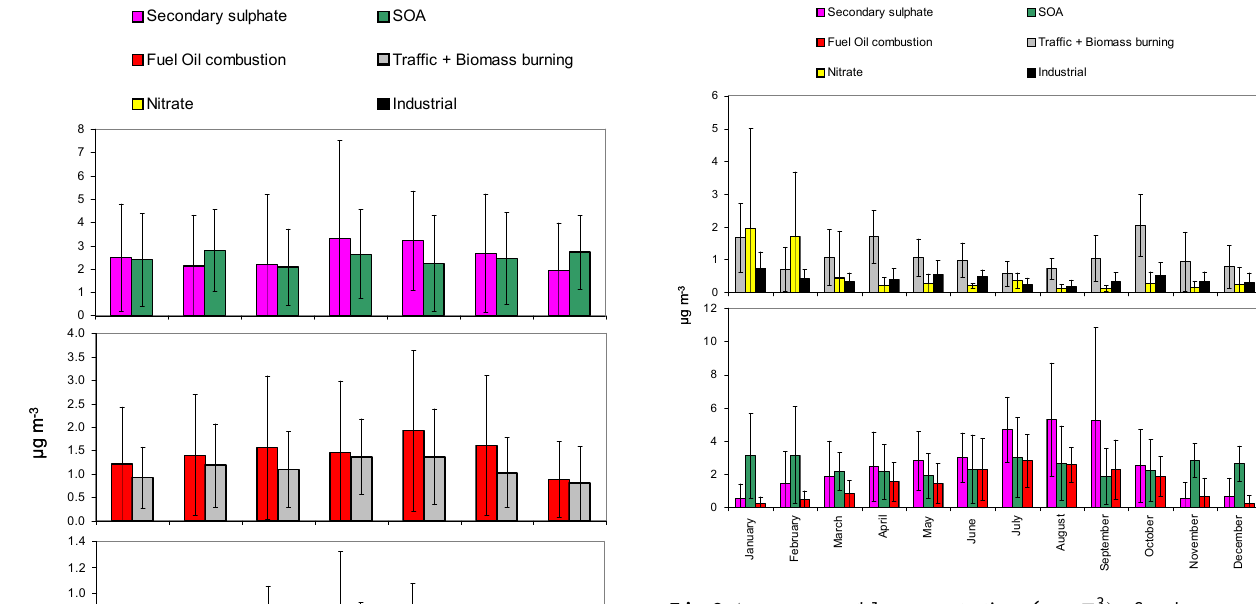
Fig. 6. Average monthly concentrations (µgm − 3 ) of each